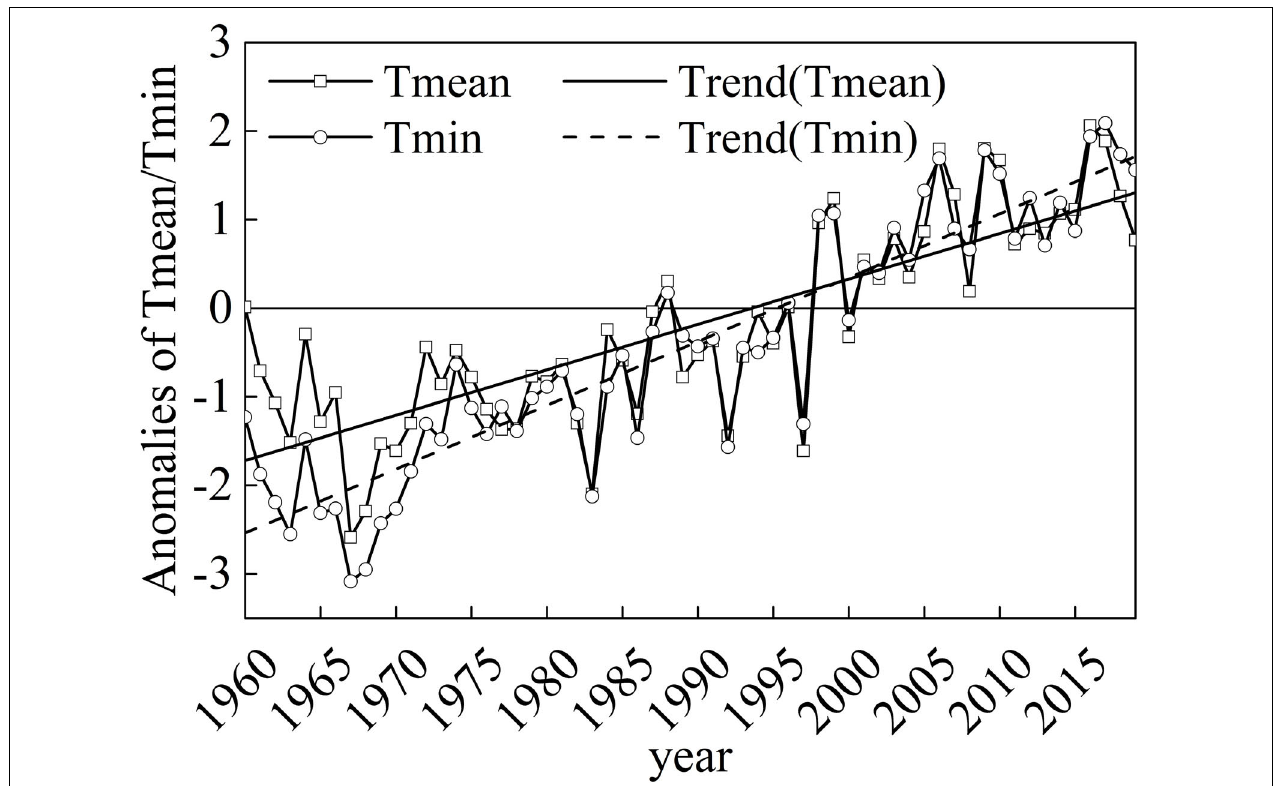
FIGURE 6 | Increase in annual mean air temperature and mean annual minimum air temperature for all 19 stations from 1960 to 2019.